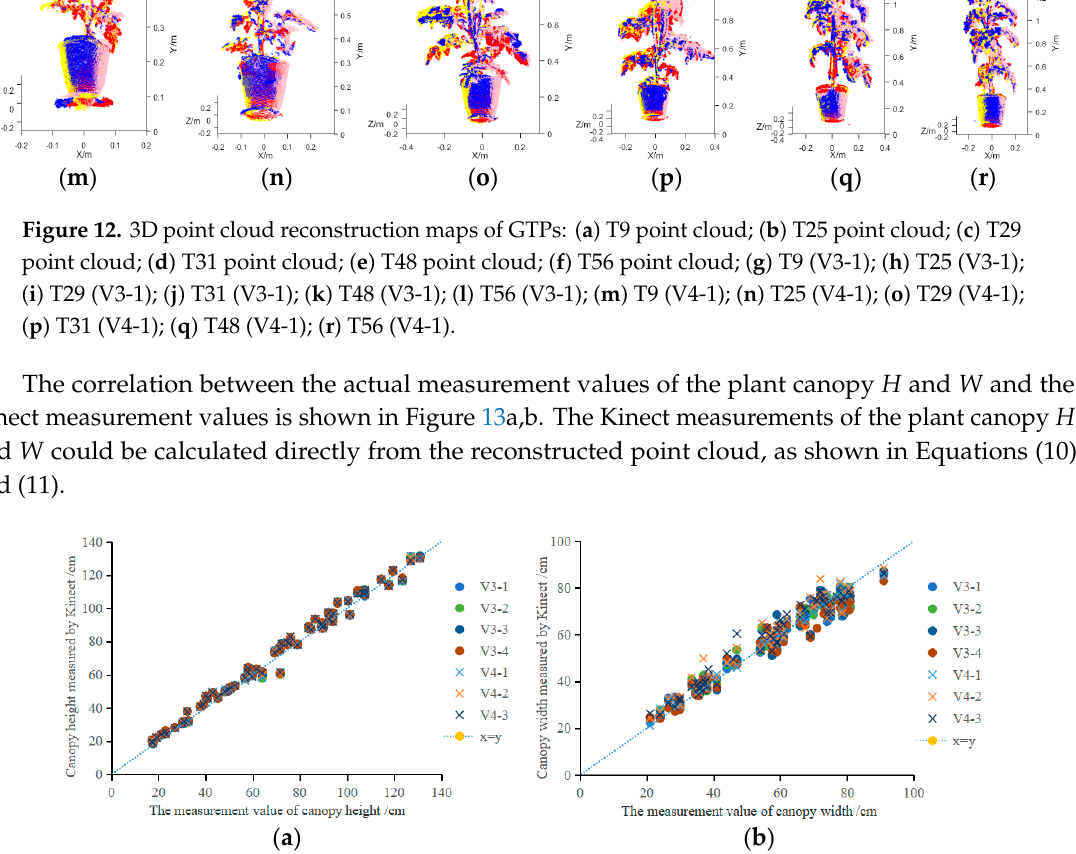
Table 4. Relationship between the calculated values and the measured values of the canopy morphological parameters by different measurement methods.